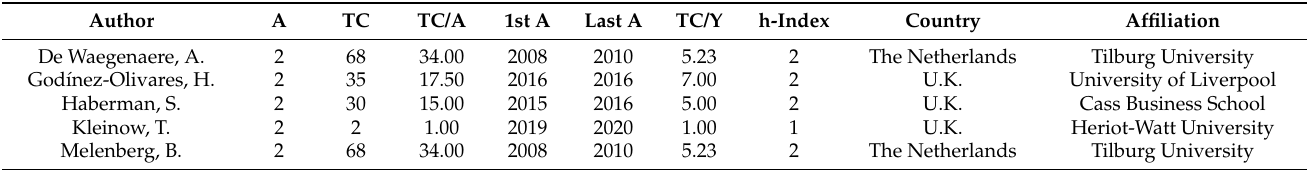
Table 15. The top 5 most productive authors on pension research in the Mathematics